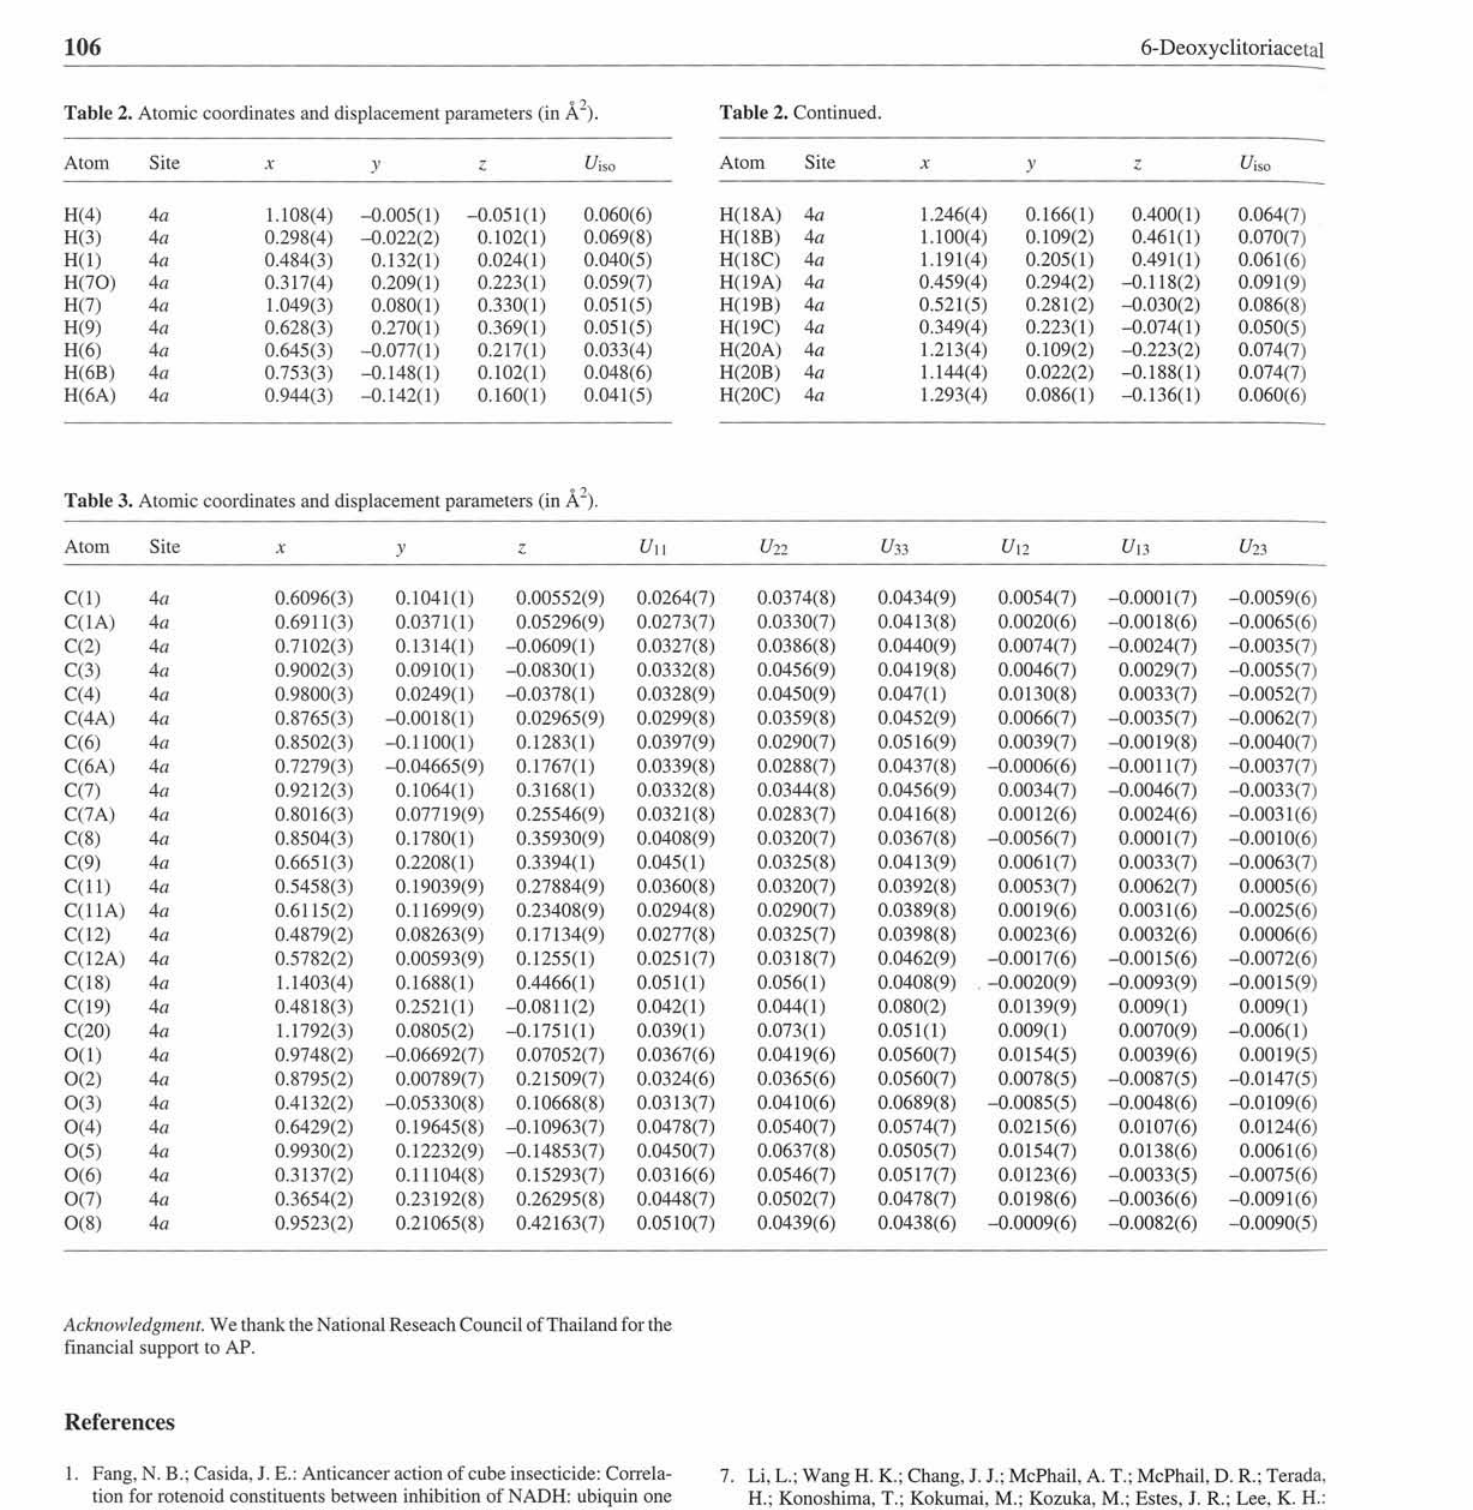
Table 2. Atomic coordinates and displacement parameters (in A").